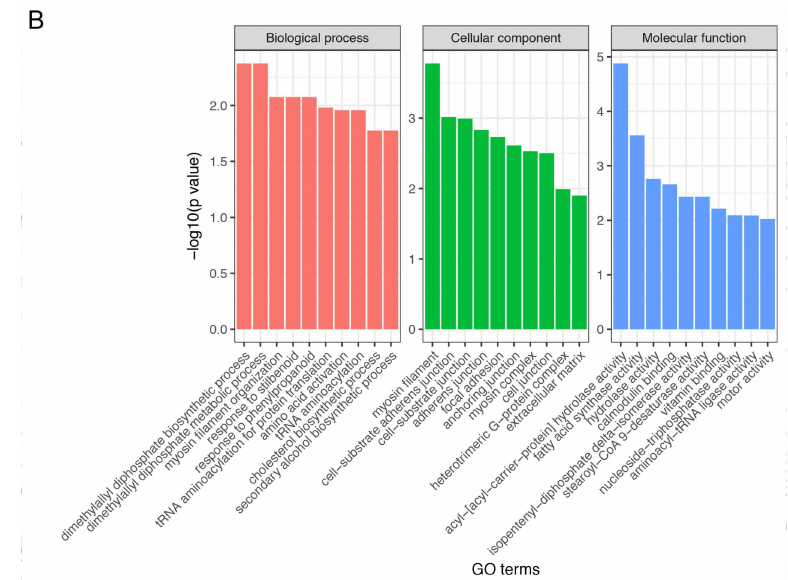
Figure 3. Gene Ontology (GO) analysis of differentially expressed genes (DEGs). ( A ) GO categories of DEGs. The x axis represents number of DEGs and the y axis represents GO terms; ( B ) The most enriched 10 GO terms in biological process, cellular component, and molecular function. The x axis represents GO terms and the y axis represents the value of − log10 ( p -value).